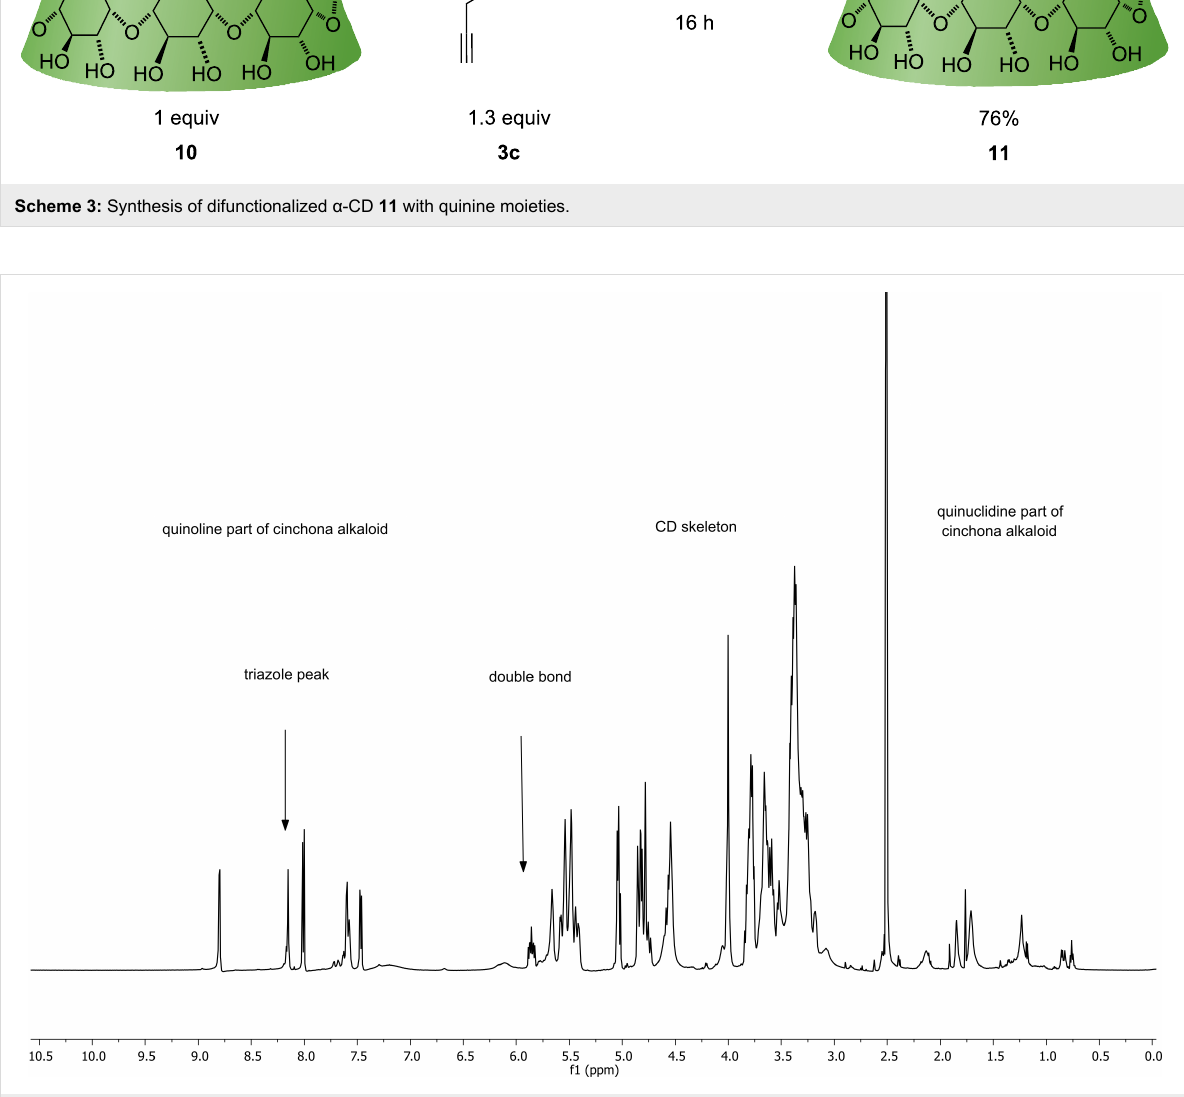
Figure 3: Representative 1 H NMR spectrum of the non-methylated quinidine– α -CD derivative 4d